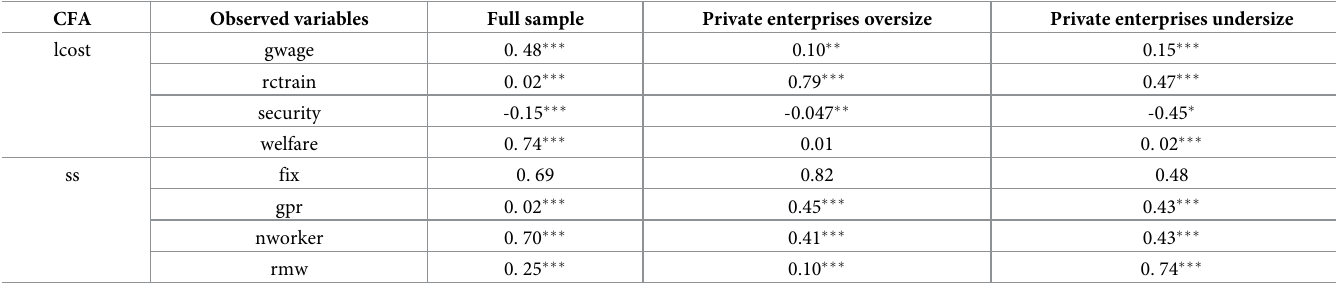
Table 2. Structural equation output